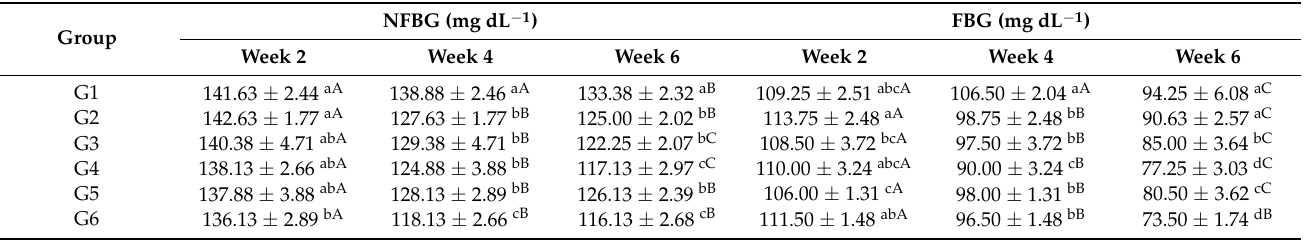
Table 2. Effect of FCM, FCM-D, and intermittent fasting and non-fasting on blood glucose level (md dL − 1 ) in obese rats fed a high-fat diet for 6 weeks, n = 8.